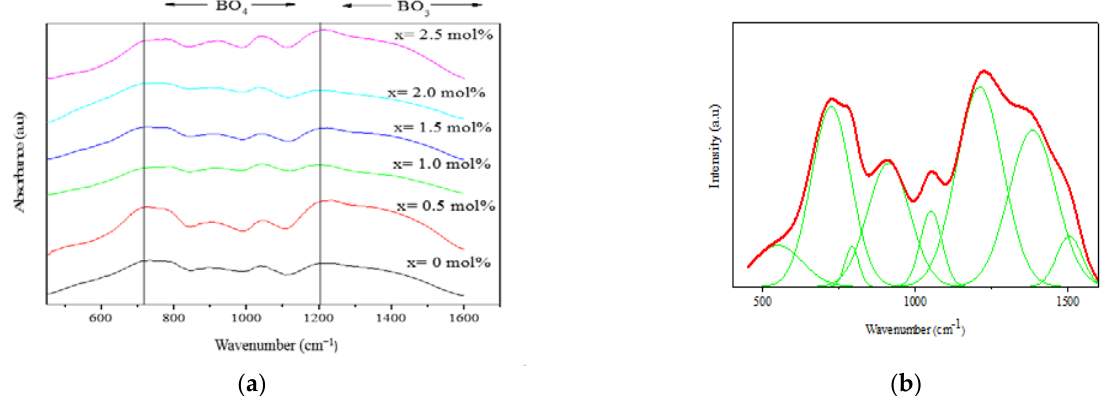
Figure 4. FTIR results of ( a ) (59.5– x ) B 2 O 3 –20Na 2 O–20CaO– x V 2 O 5 –Er 2 O 3 –0.5AgCl ( x = 0, 0.5, 1.0, 1.5, 2.0 and 2.5 mol%) and ( b ) deconvolution of 59B 2 O 3 –20Na 2 O–20CaO–0.5V 2 O 5 –Er 2 O 3 –0.5AgCl.